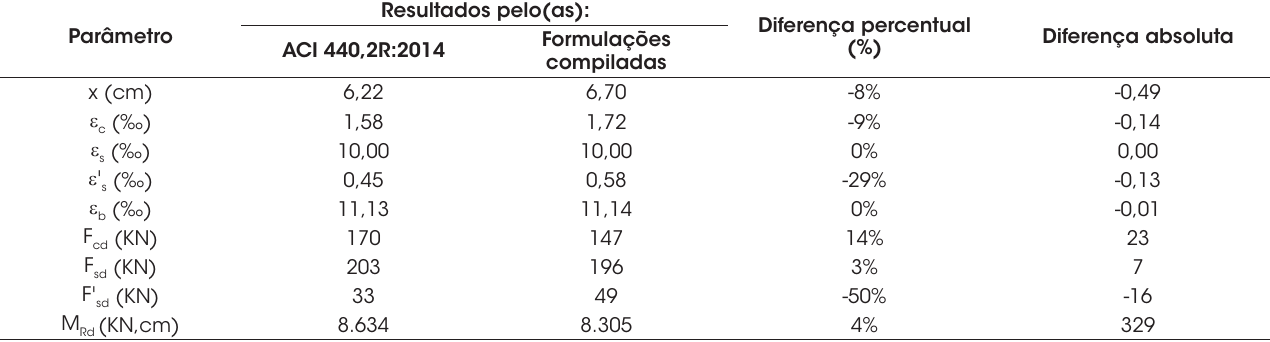
Parâmetros envolvidos no cálculo do momento resistente inicial da viga